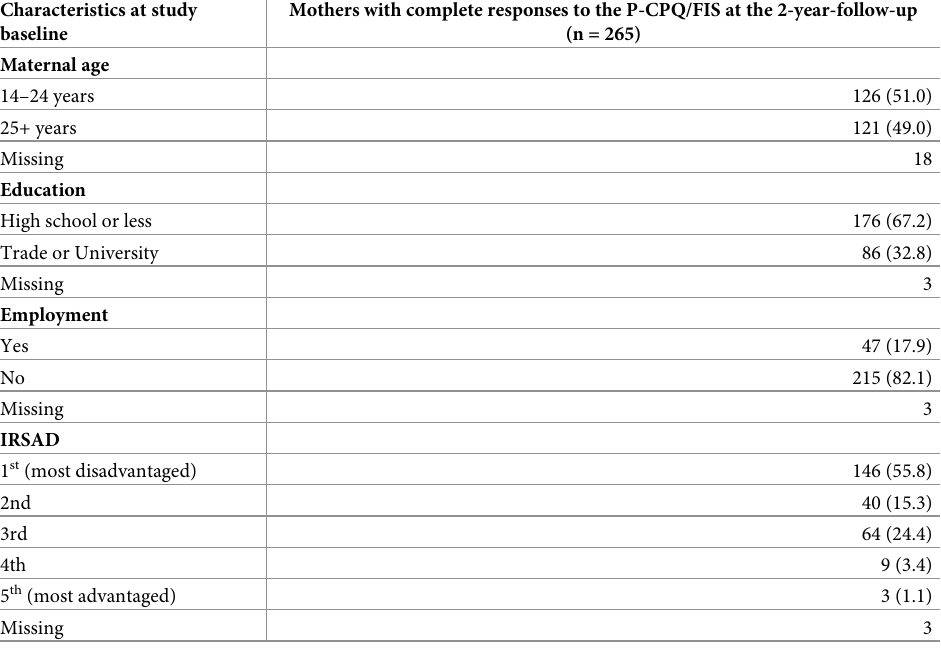
The redundancy analysis indicated no redundancy between the items since the wTOs between item pairs were weak and the strongest redundancies were not theoretically meaningful. For